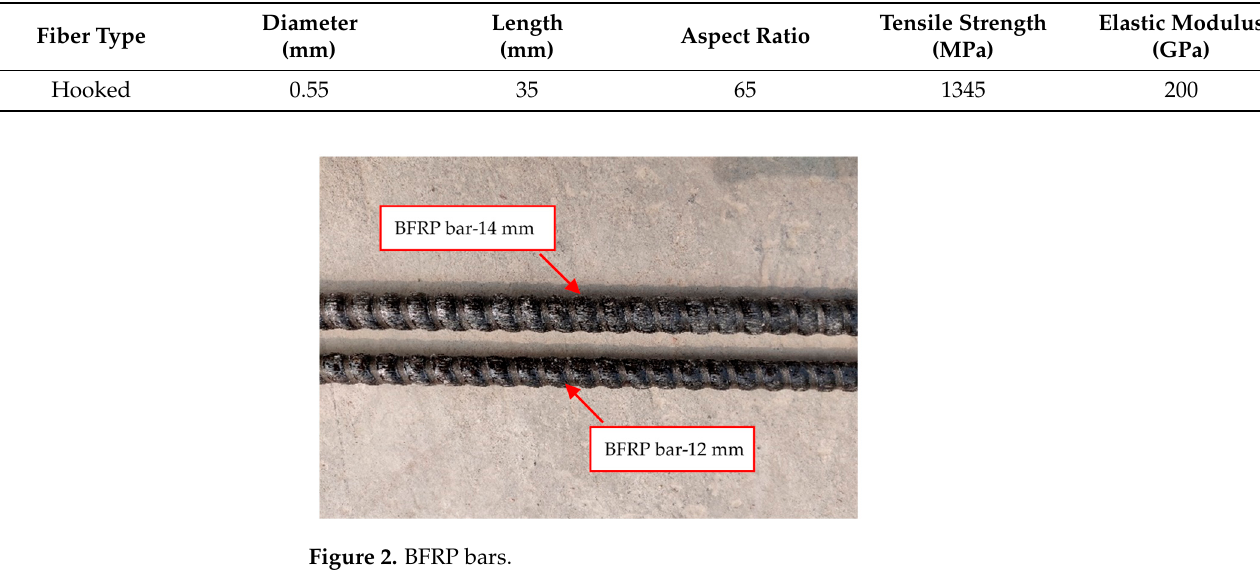
Table 2. Properties of SF.